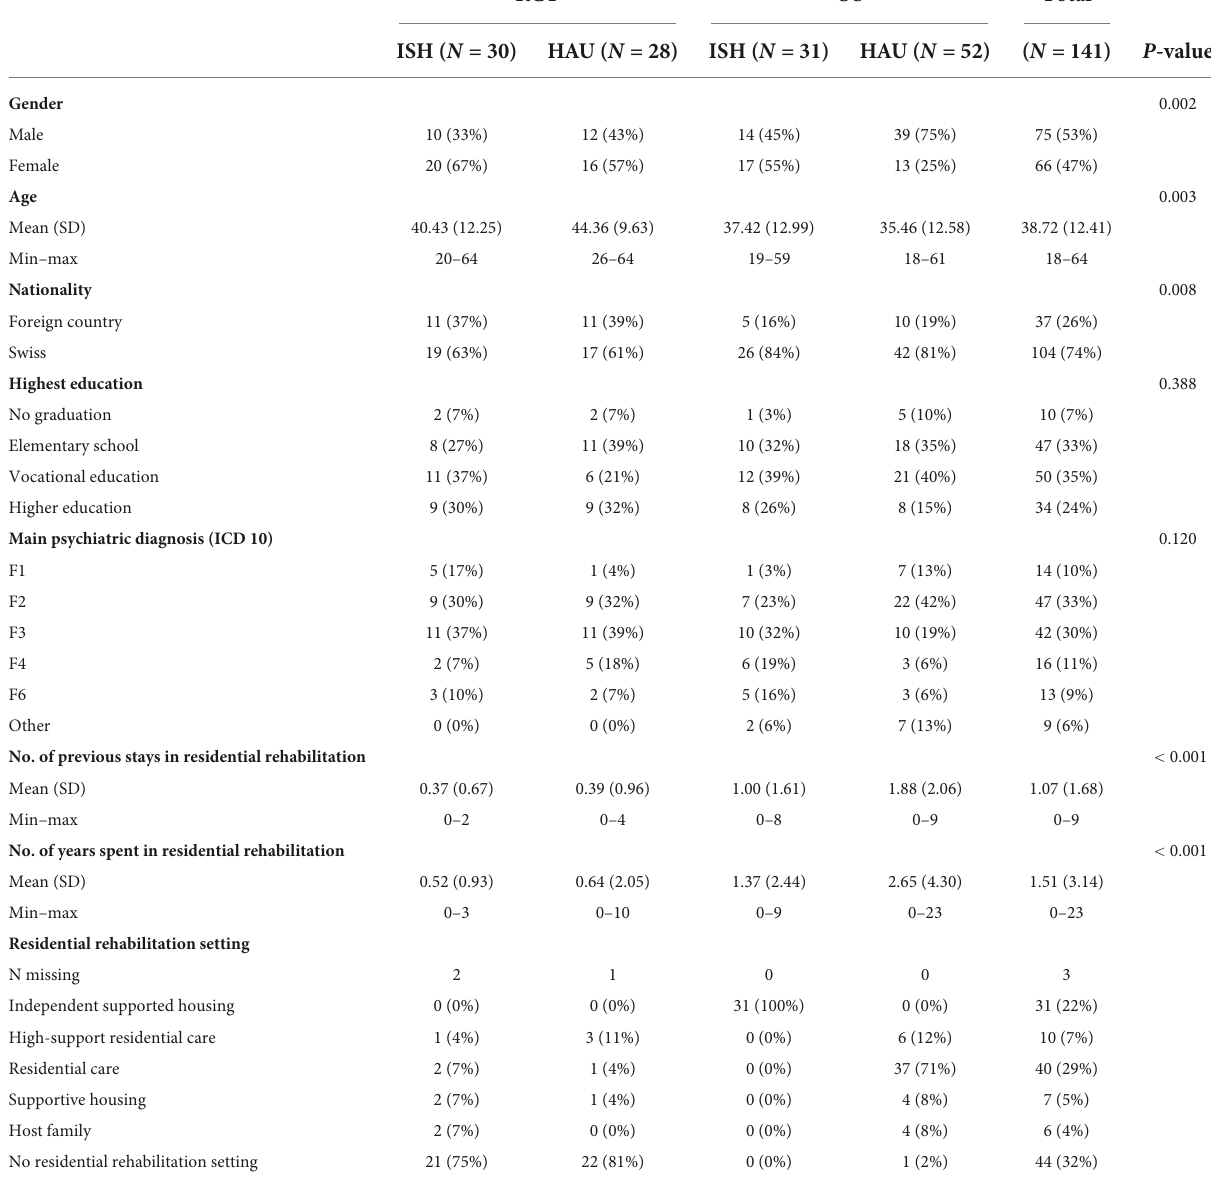
TABLE 1 Sample characteristics at